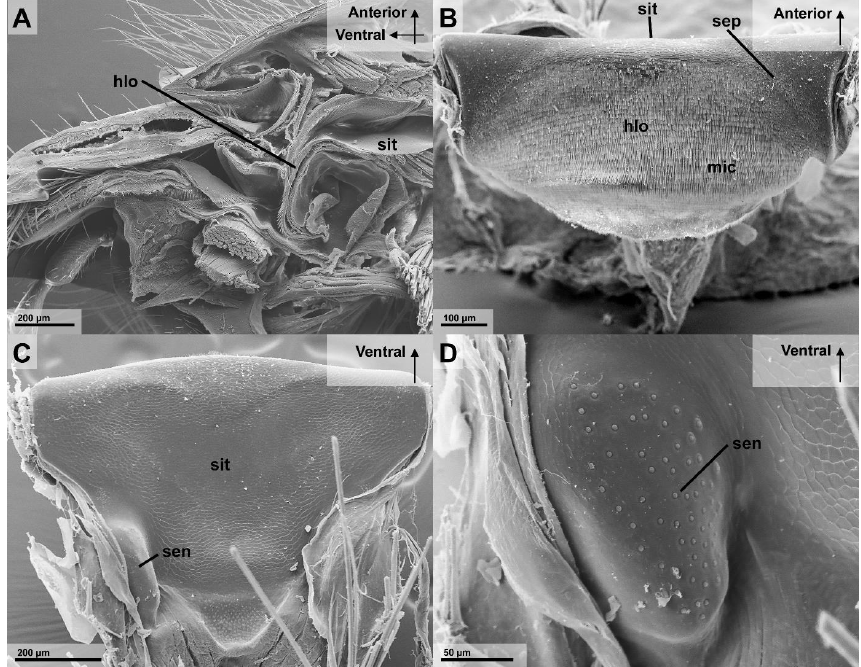
Figure 6. Preoral filtering structures inside the head of Vespula germanica , focused on the parts of the hypopharynx (SEM). ( A ) The anterior parts of the head in a sagittal cut. The preoral cavity and the functional mouth opening are visible. ( B ) An overview of the hypopharyngeal lobe, viewed from the frontal side, with microtrichia and a field of secretory pores visible. ( C ) The surface structure of sitophore, viewed from the dorsal side ( D ) The detail of the elevated patch of sensilla at the posterior side of the sitophore. [Abbreviations: hlo: hypopharyngeal lobe, mic: microtrichia, sen: sensilla, sep: secretory pores, sit: